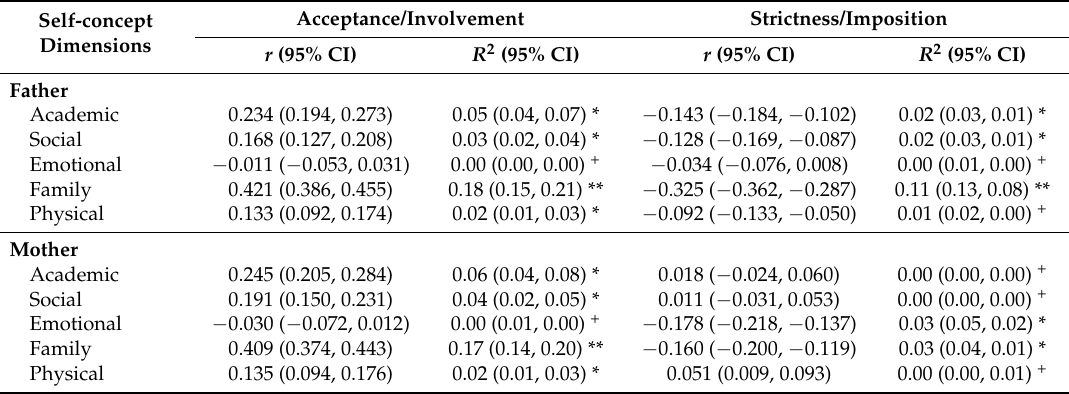
Table 5. Correlations and R 2 between two main parental socialization dimensions with five self-concept